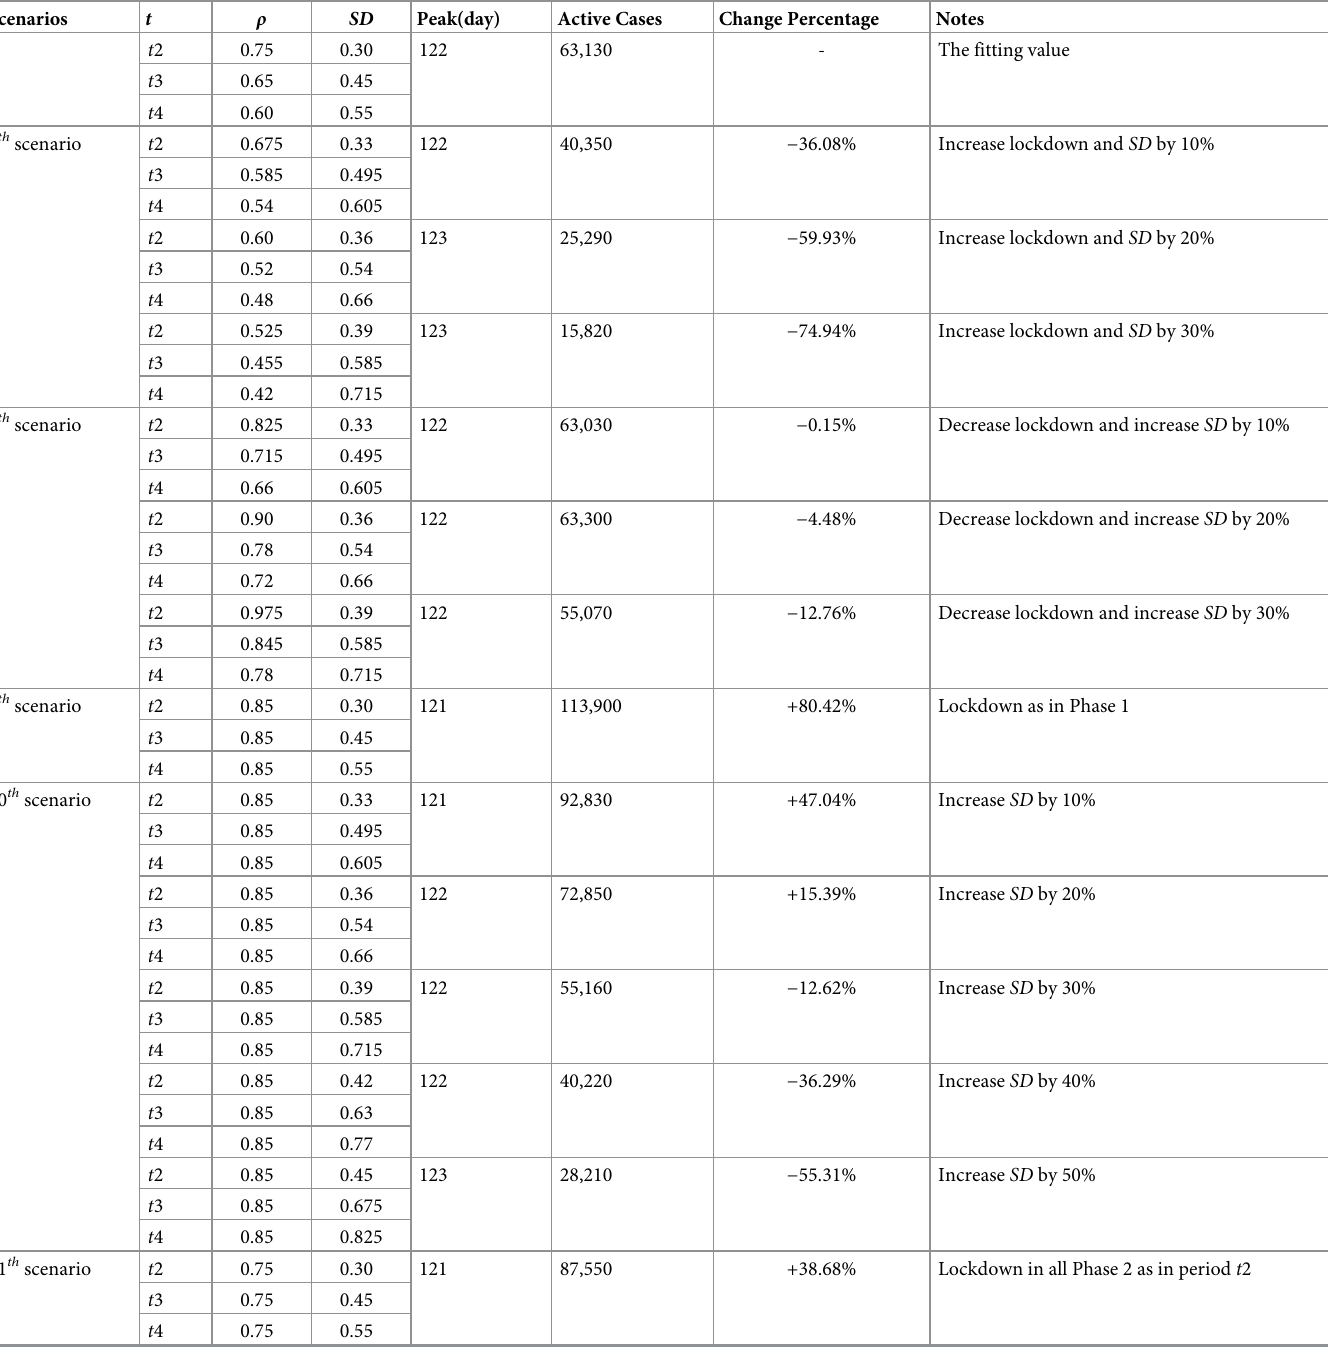
Table 6. Results of different scenarios for Phase 2, (7 th –12 th )